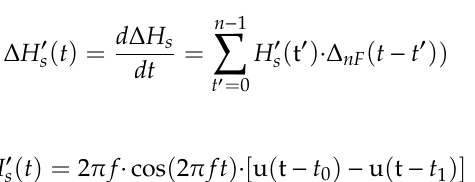
Table 3. Error comparison between H s and H’ s methods.